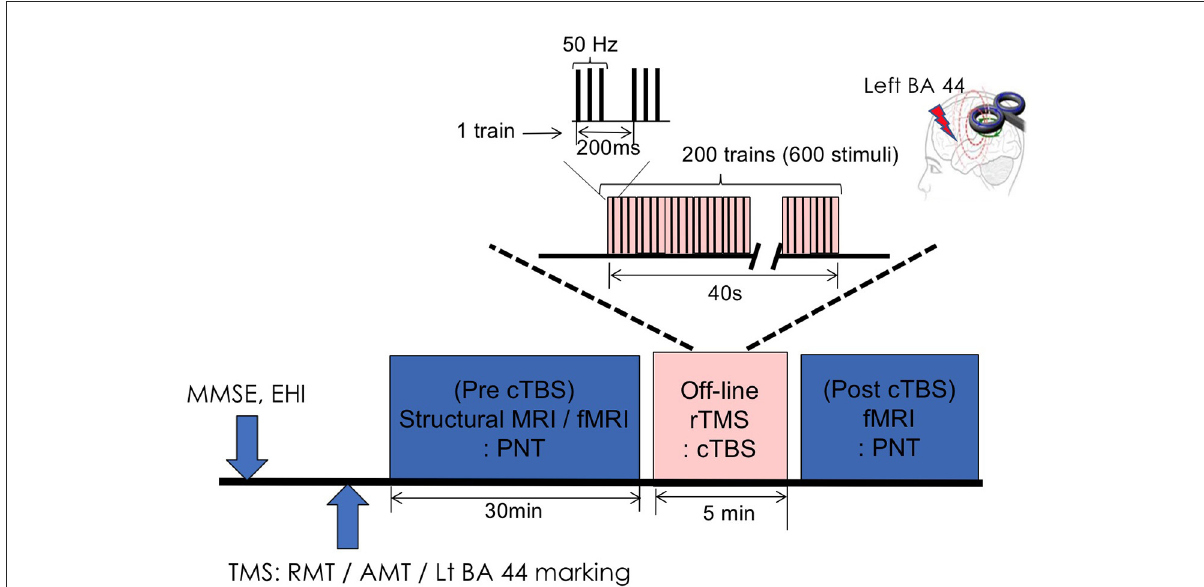
FIGURE1 Experimental design. MMSE, Mini Mental Status Examination; EHQ, Edinburgh Handedness Inventory; TMS, transcranial magnetic stimulation; RMT, resting motor threshold; AMT, active motor threshold; BA, Brodmann area; rTMS, repetitive transcranial magnetic stimulation;